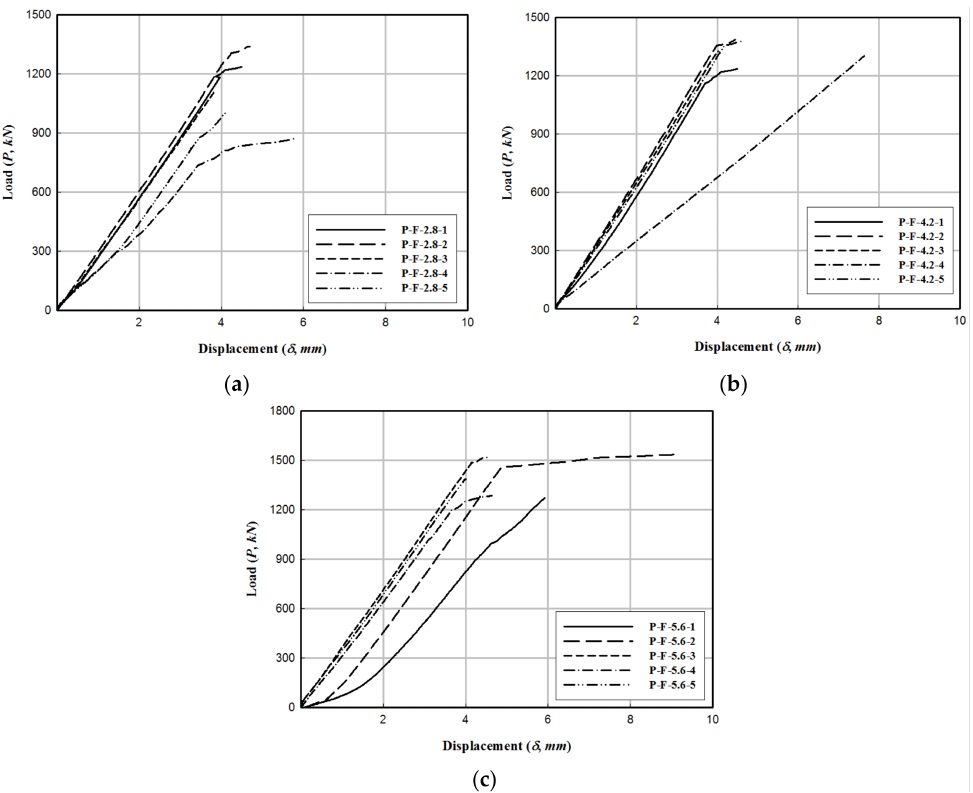
Figure 10. Load–displacement relationship of PFRP − FFRP. ( a ) P − F − 2.8. ( b ) P − F − 4.2. ( c ) P − F − 5.6.